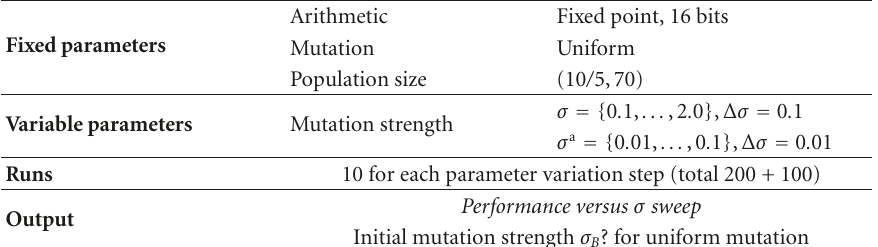
Table 7: Test no. 3 b . Initial mutation step σ for Uniform mutation.